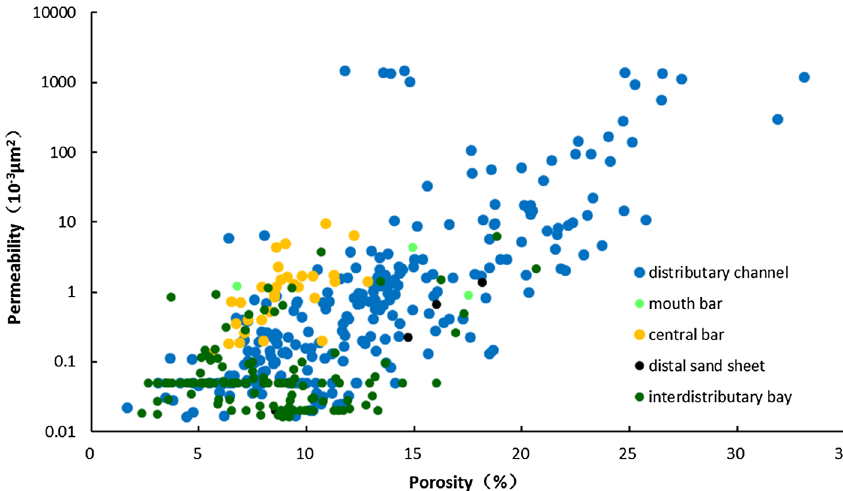
Fig. 8 Cross plots of